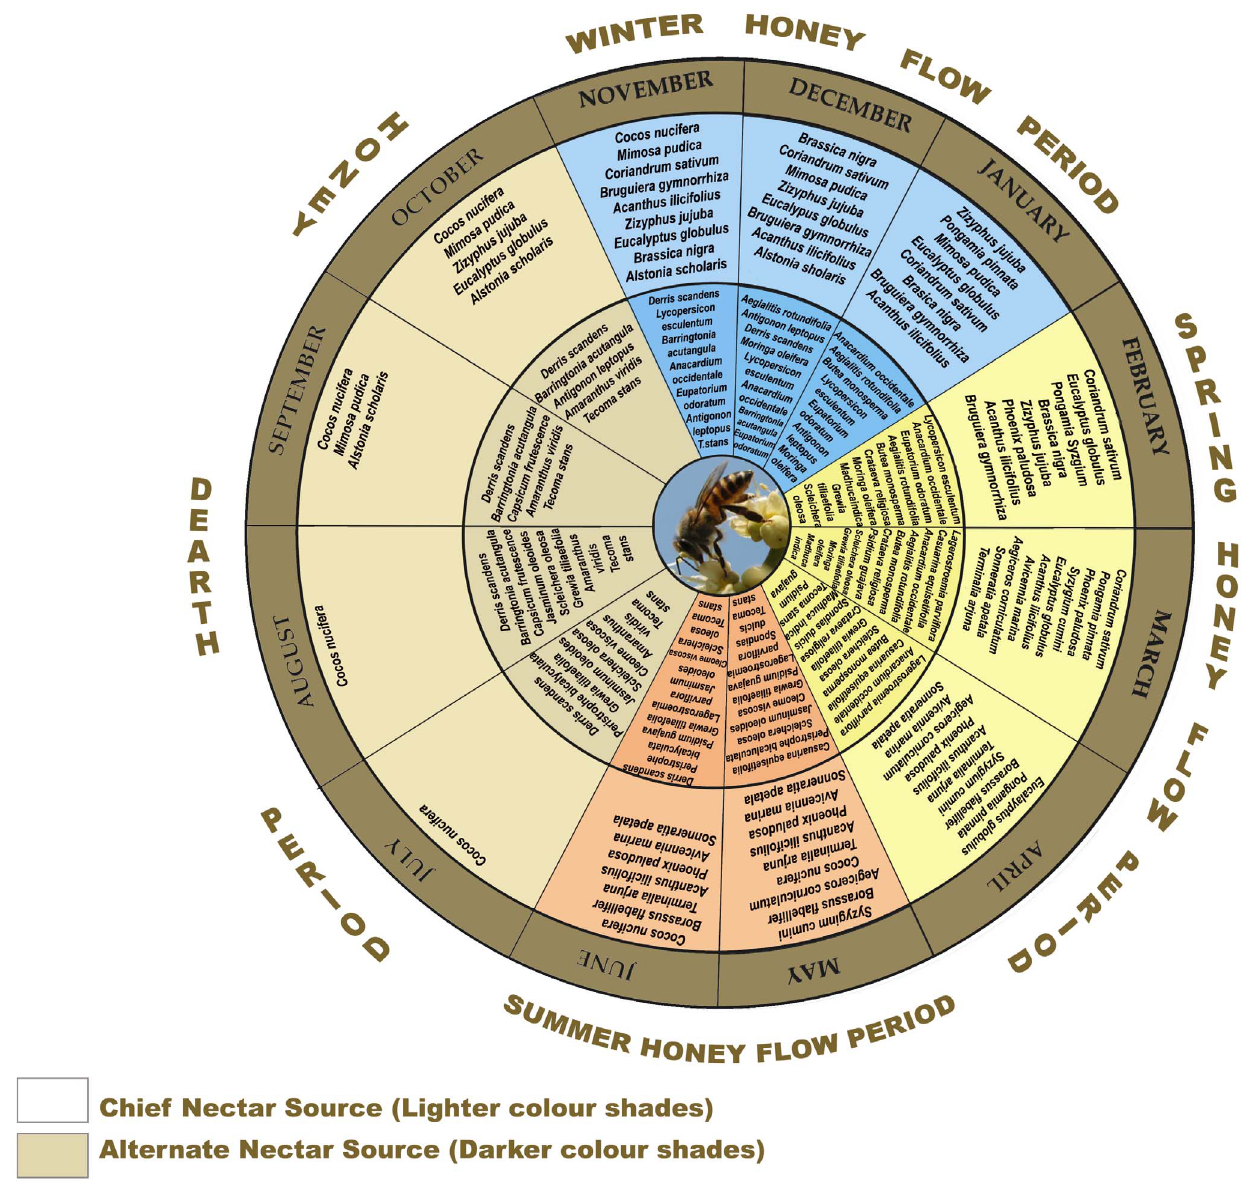
Figure 4. Nectar calendar of Bhadrak and Kendraparha districts, Orissa, India.